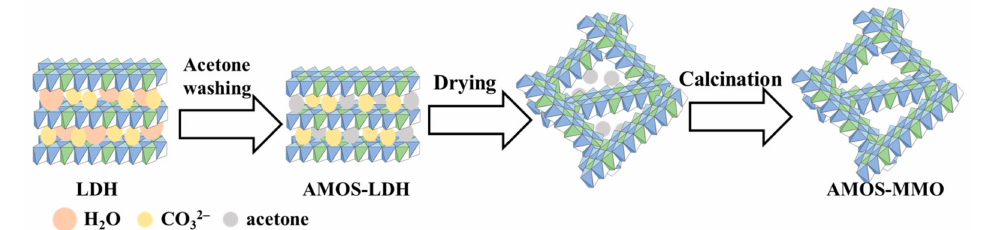
Figure 5. The schematic diagram of synthesis of AMOS-LDH and AMOS-MMO (adapted [61] with permission from Elsevier,